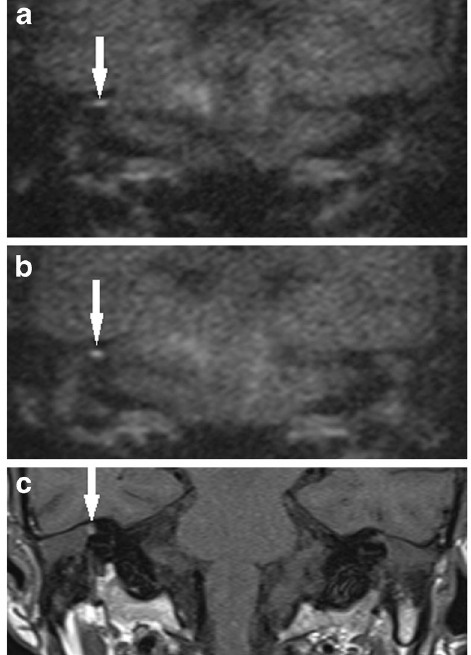
Fig. 8 False positive case of proteinaceous fluid in the mastoid remnant. The coronal a b1000 image shows a small focus of high signal ( white arrow ) postero-medially at the mastoid remnant, which returned low signal on the ADC map, but was distant from the site of the original middle ear cholesteatoma which was excised with high surgical confidence. At the clinico-radiological meeting, it was decided to monitor this annually with DWI. b The subsequent coronal b1000 image showed the high signal focus ( white arrow ) remained unchanged over 2 years making it more unlikely to represent residual disease. c The corresponding non-contrast enhanced T1 weighted image showed the lesion ( white arrow ) returned high T1 signal suggestive of proteinaceous fluid given its